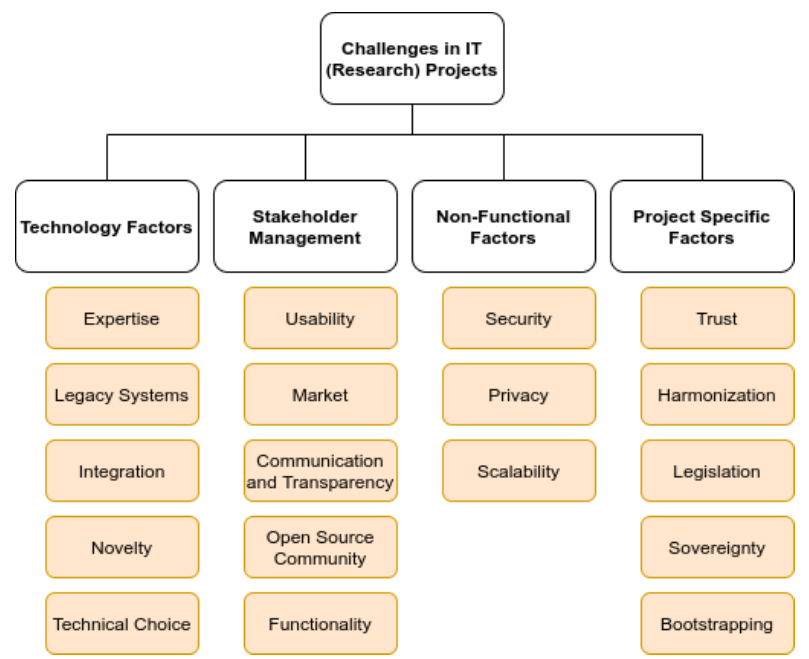
Figure 7. Challenges based on the established